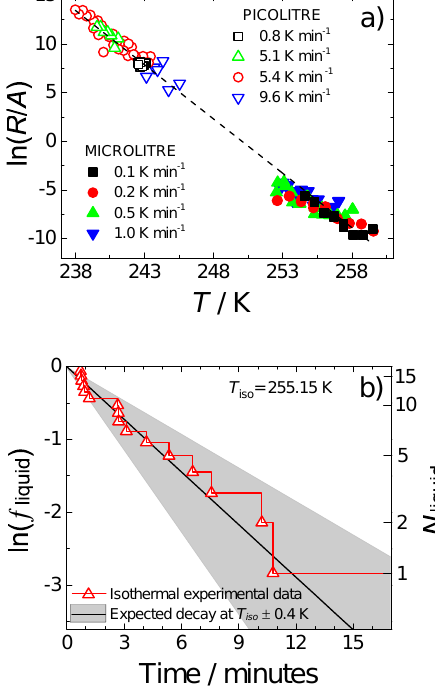
Figure 4. Droplet freezing data for kaolinite (KGa-1b). (a) shows freezing rates normalised to surface area, R/A , against temperature determined from droplet freezing experiments with a range of cool- ing rates. Open symbols represent PICOLITRE experiments from Murray et al. (2011) and closed symbols represent MICROLITRE experiments. The black dashed line shows a linear fit to all data (ln( R/A ) =− 1.12 T + 280). Temperature uncertainty for the MI- CROLITRE data (not shown) is estimated at ± 0.4K, and un- certainty in R/A (not shown) is estimated at − 17 and + 25%. (b) shows the exponential decay of liquid droplets during an isother- mal experiment at 255.15K together with a modelled experiment at the same temperature using the linear fit to all data in (a) . The grey area follows the experimental uncertainty in T around the modelled isothermal. The experiment duration was 17min, at which point one droplet remained